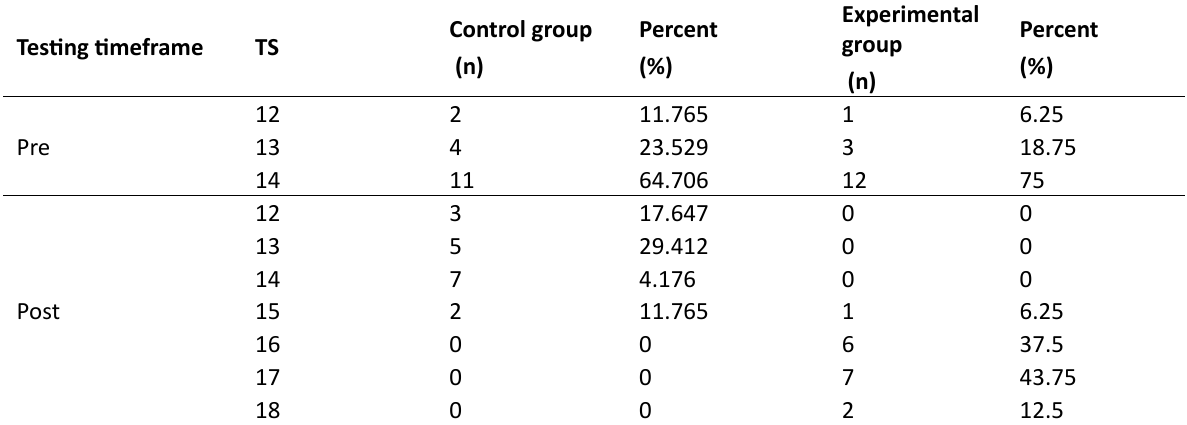
Table 2. FMS total score distribution in control and experimental groups pre testing and post testing conditions